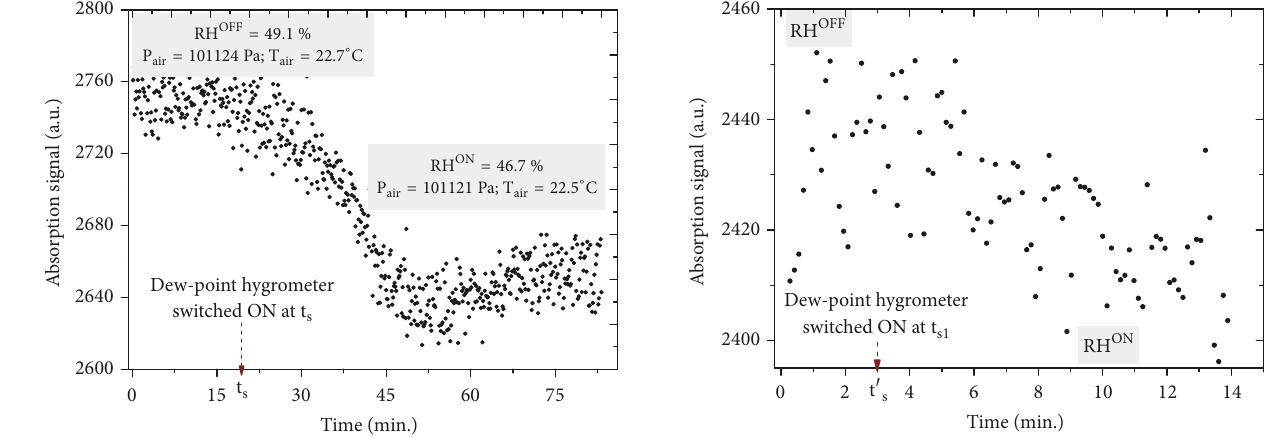
Figure 7: Absorption signal integrated over the entire absorption line of water vapor in humid air at atmospheric pressure showing the effect of starting the condensation hygrometer.